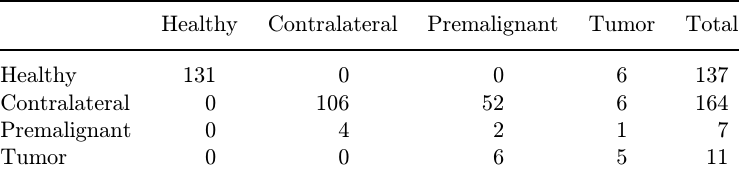
Table 7. PC-LDA for e±ciency of RS in identifying healthy, contralateral, premalignant and tumor conditions at lip subsite.